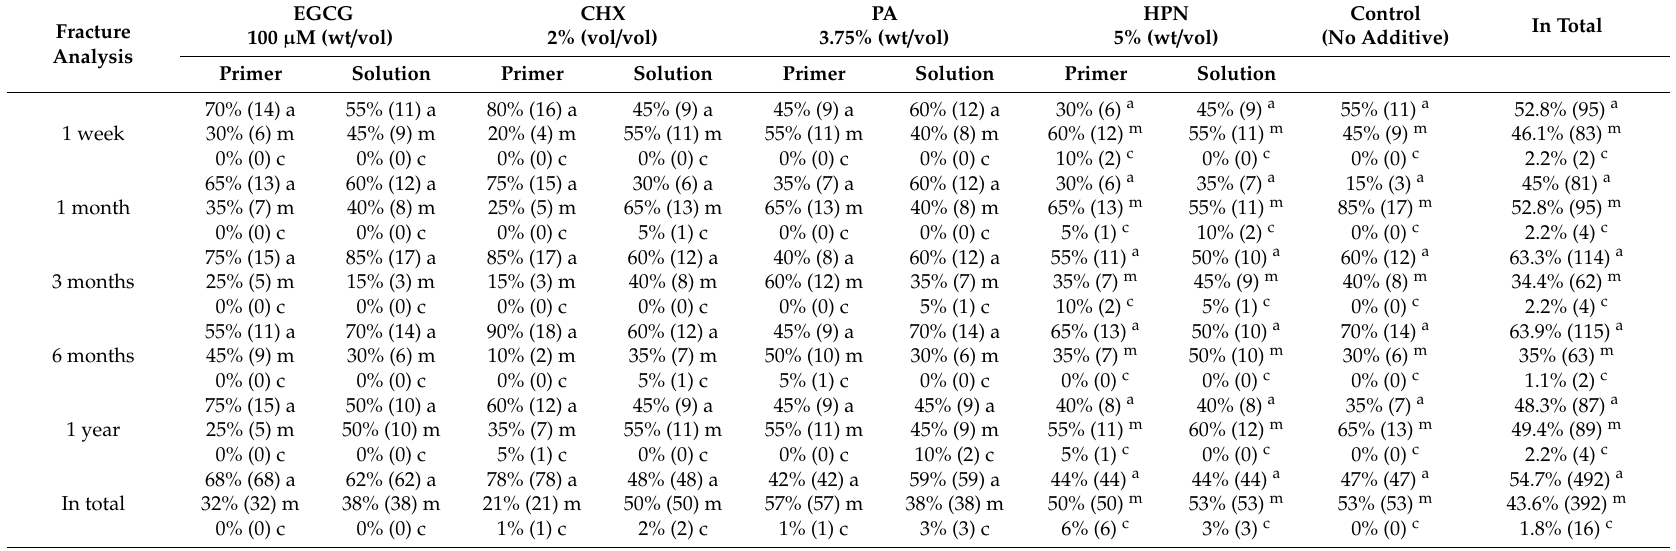
Table 4. Fracture analysis of the test groups as a function of immersion duration. Prevalence of the defined fracture patterns is presented in percent (in total in brackets). Superscript letters identify fracture mechanism: a, adhesive; m, mixed; c,